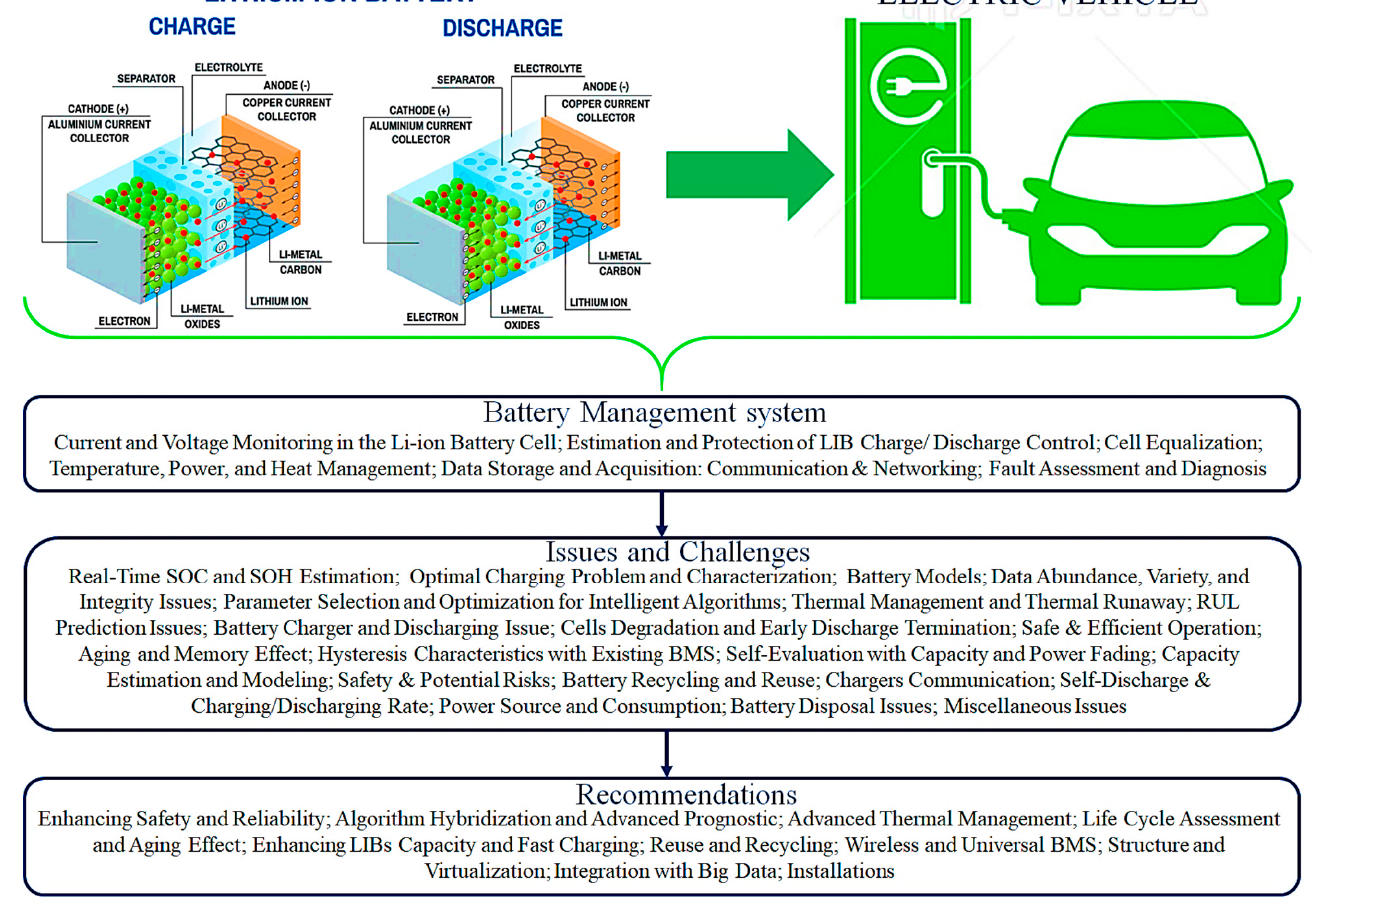
Figure 3. Overview of study.